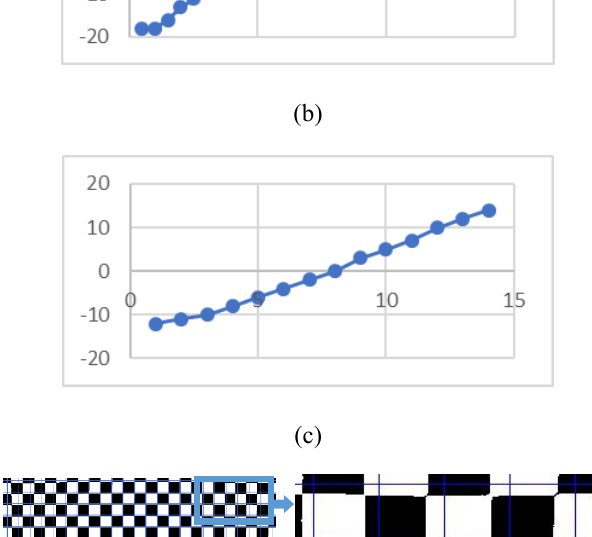
Figure 4. (a) At each point, check area around it to find intersections; (b) The intersections are accurately marked red in the checkerboard image; (c) The image of the dot-centroid position and grid vertices added over the image of intersection points.